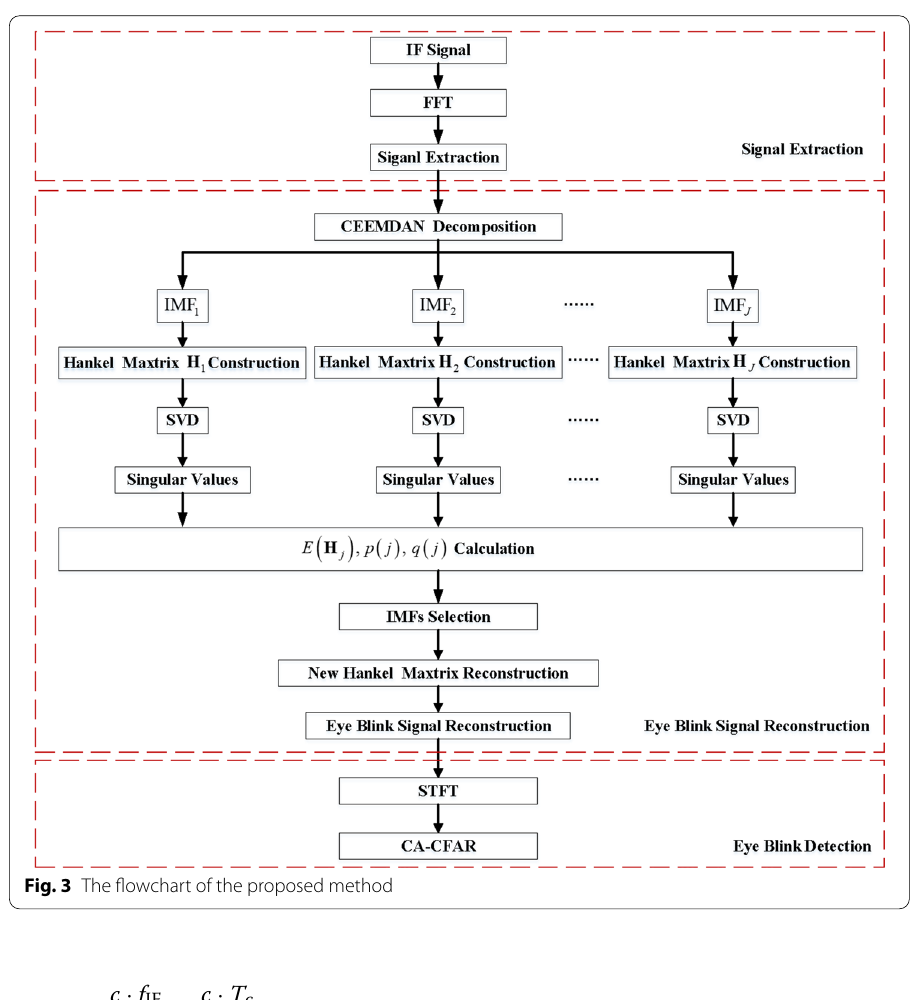
Fig. 3 The flowchart of the proposed